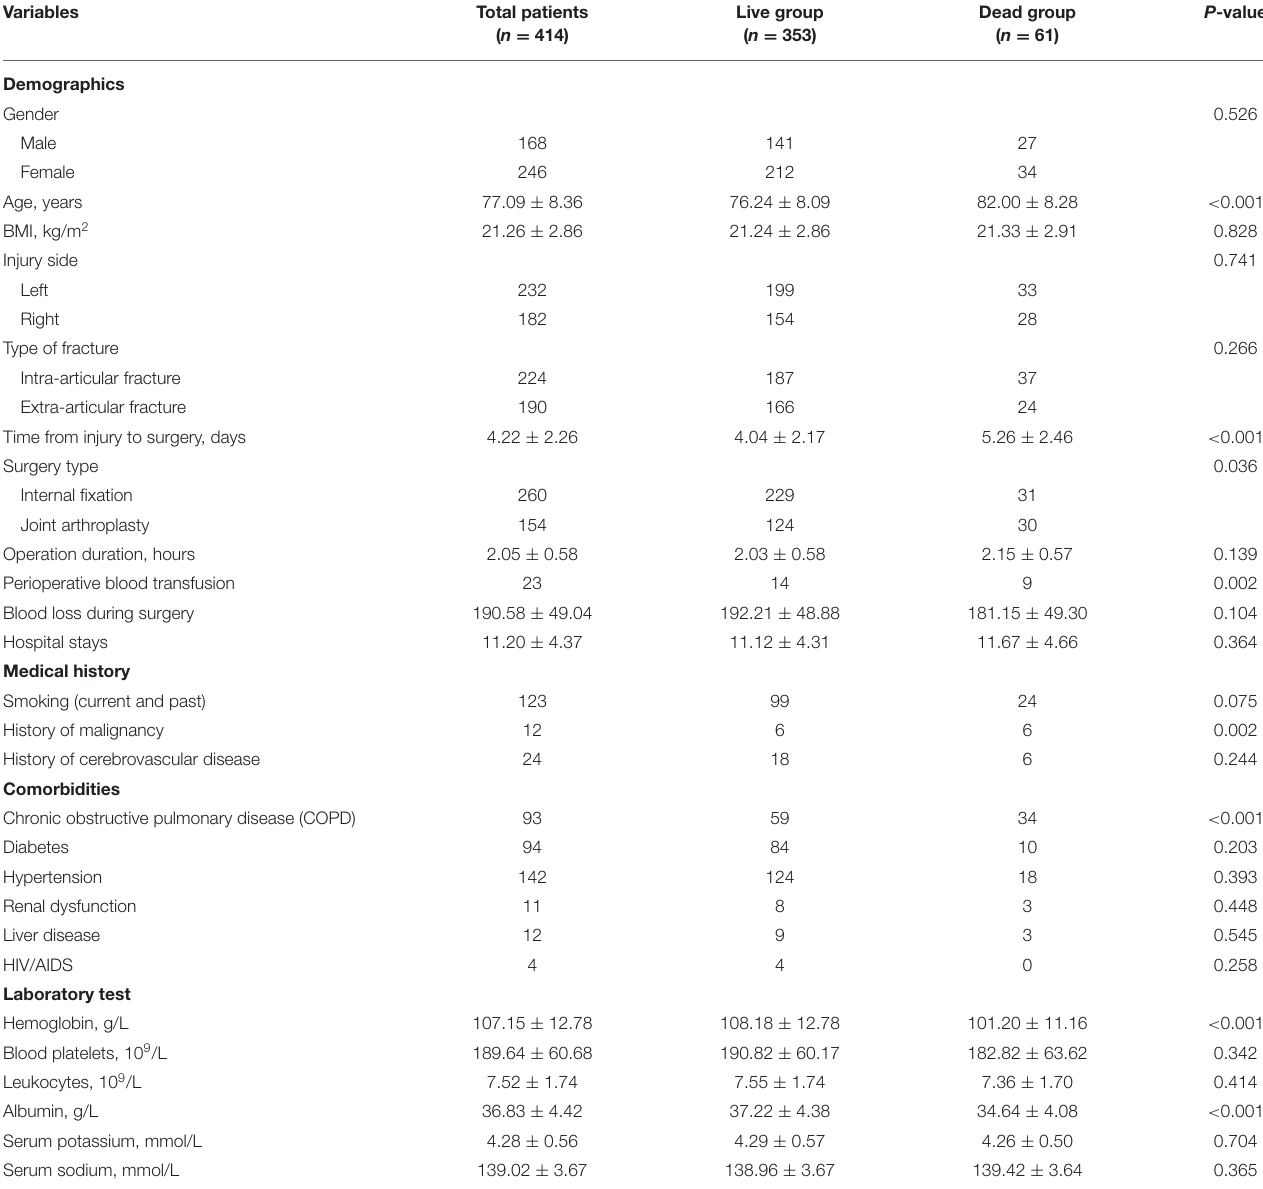
TABLE 3 | The baseline characteristics of the training